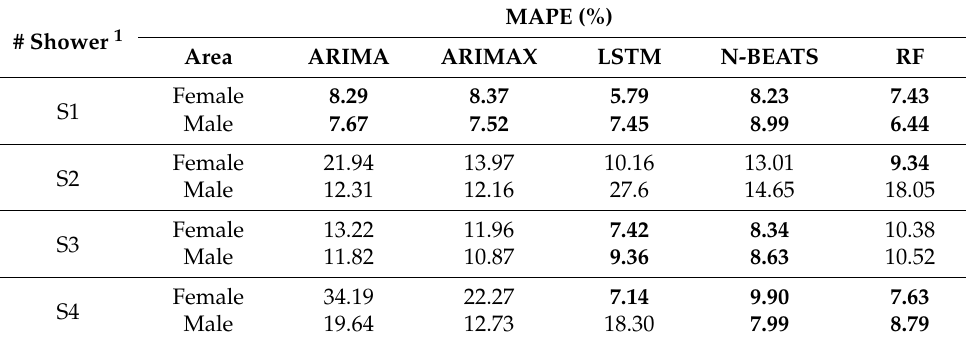
Figure 5. Comparison of observed and forecasted daily BWD of each shower room with ARIMA, ARIMAX, LSTM, RF, and N-BEATS models, ( a , c , e , g ) for female rooms, ( b , d , f,h ) for male rooms. Table 4. MAPE-based performance evaluation of ARIMA, ARIMAX, LSTM, N-BEATS, and RF models (bold denotes correct findings for the corresponding shower